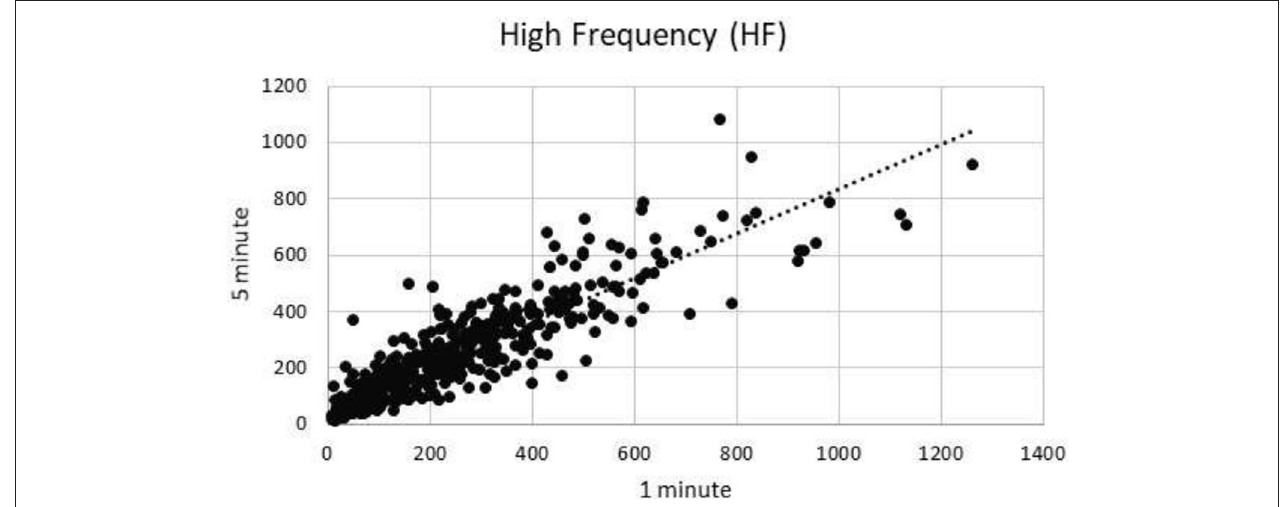
FIGURE 1 | High frequency component correlation.